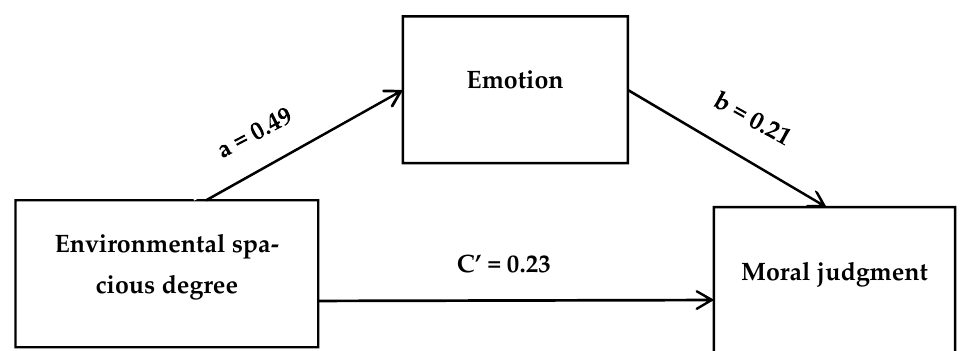
Figure 4. The role of emotion in the relation between environmental spacious degree and moral judgment (a represents the regression coefficient when spaciousness predicts emotional scores; b represents the regression coefficient when mood score predicts moral judgment score; c’ represents the effect of spaciousness on moral judgments after considering emotions).